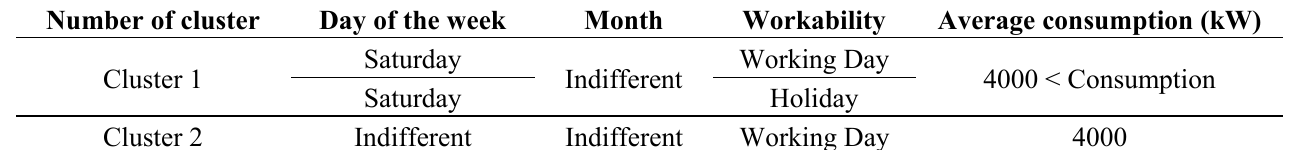
Table 1. Analysis of results per